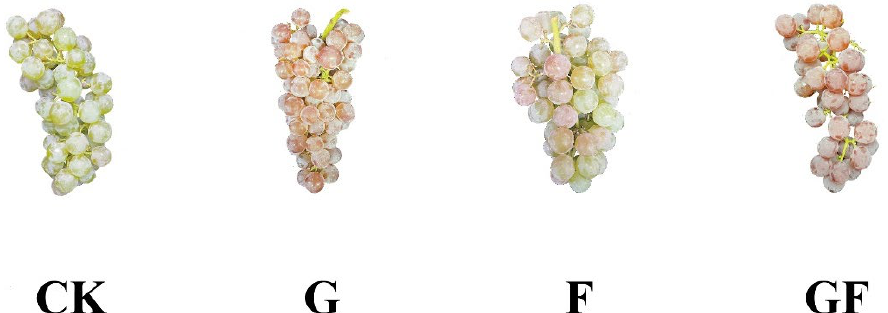
Figure 1. Effects of girdling and foliar fertilization with K on the visual appearances of ‘Hanxiangmi’ table grapes at harvest. CK: the control; G: girdling treatment; F: foliar fertilization treatment of K; GF: both of girding and foliar fertilization treatments.